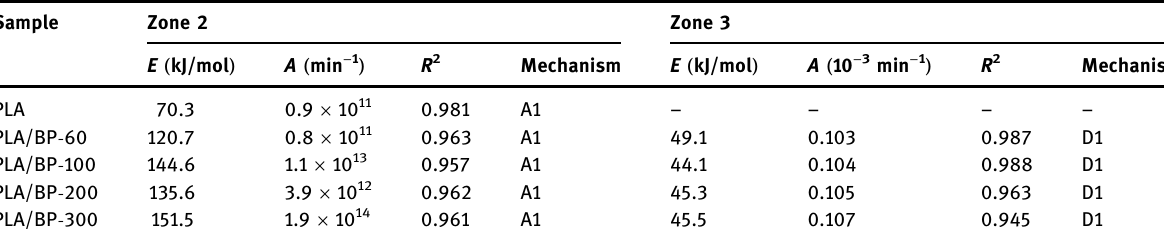
Table 4: Pyrolysis kinetic parameters of BP, PLA and biocomposites Sample